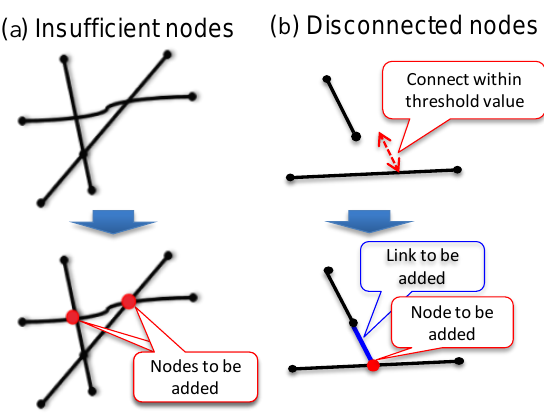
Figure 4. Topological generation from each OSM data.